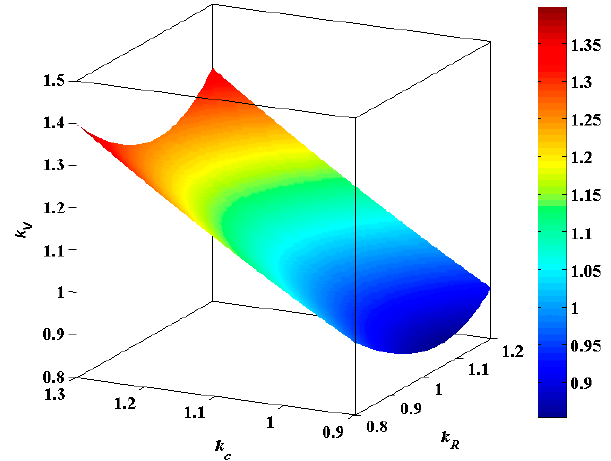
Figure 13. The optimization contour surface between the total volume and the inner radius and insulation distance.